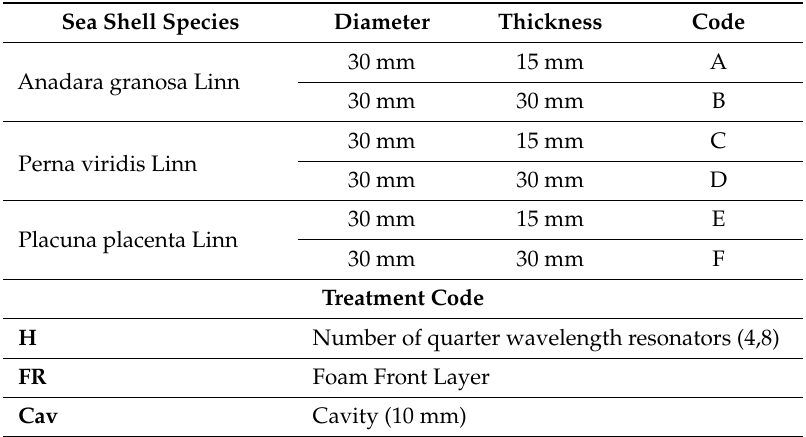
Table 1. The geometrical dimension and treatment of test samples.